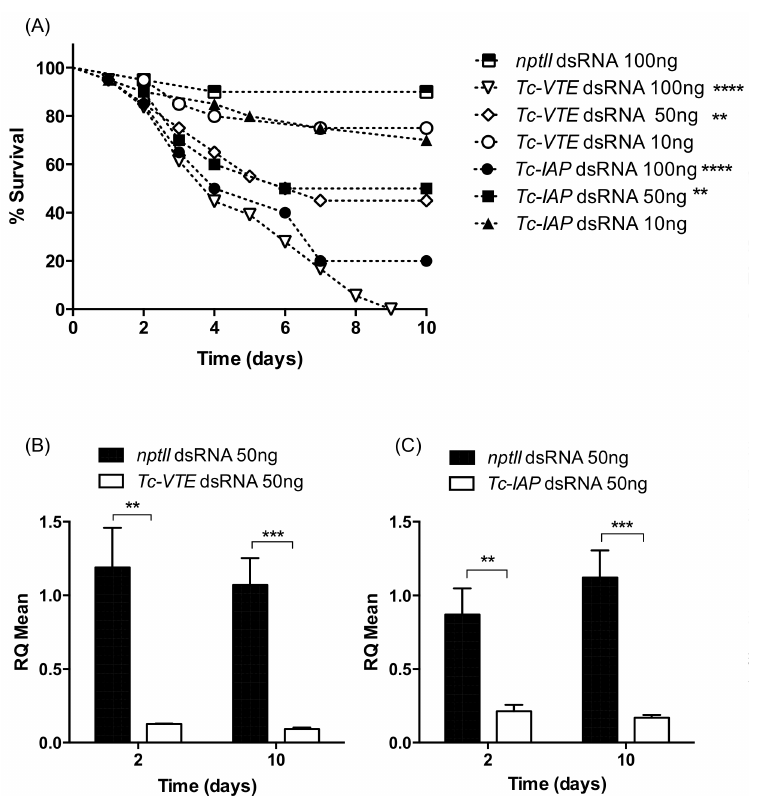
Figure 3. ( A ) T. castaneum survival after injection of Tc-VTE and Tc-IAP dsRNAs into pre-pupal stage larvae ( n = 20 per treatment). Relative expression of ( B ) Tc-VTE and ( C ) Tc-IAP mRNAs after injection of target dsRNAs into pre-pupal stage larvae. Error bars indicate ± SD of the mean from three biological replicates ( n = 5 insects per treatment), each with three technical replicates. RQ set to 1.0 for nptII control day 2 biological replicate 1. Asterisks depict significant differences **** p < 0.0001; *** p <